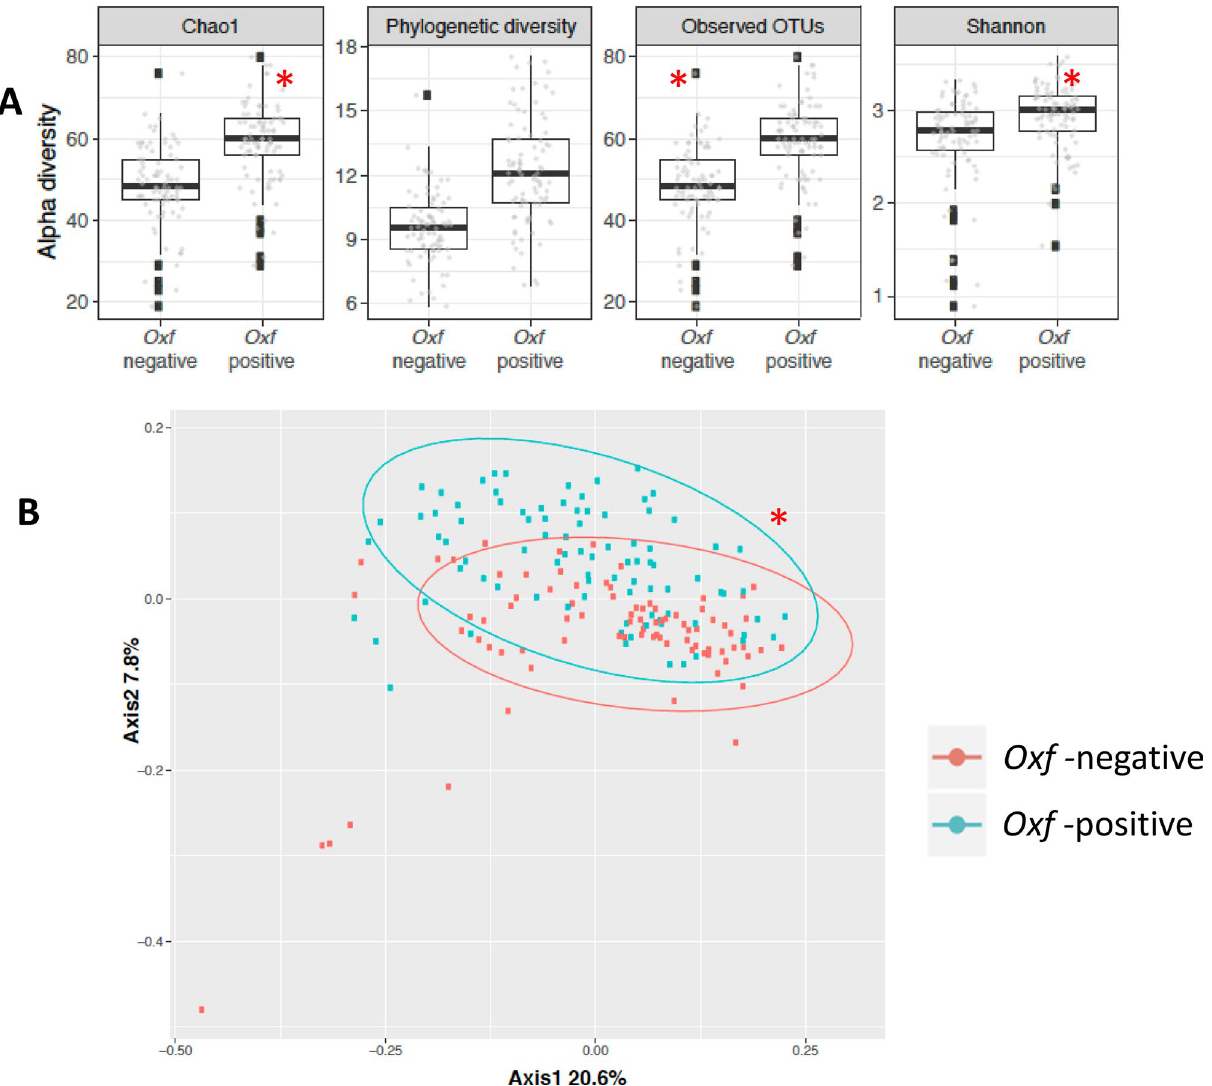
Figure 3. Alpha- and beta-diversity of microbiota in 173 fecal samples. from 64 study subjects, according to baseline O. formigenes status. Panel ( A ) Alpha-diversity measurements. Chao1, phylogenetic diversity, observed OTUs, and Shannon diversity according to Oxf status at baseline. Panel ( B ) Analysis of Beta-diversity, Unweighted UniFrac distances, according to O. formigenes status. * p < 0.05. Figure created by R software Ggplot2